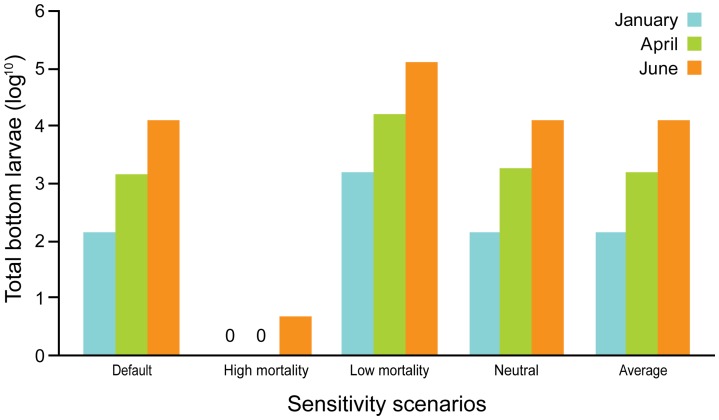
Sensitivity scenario analyses.Sensitivity testing on the effect of mortality and sedimentation velocity settings on numbers of settled larvae for three different timings of release (January, April, June).